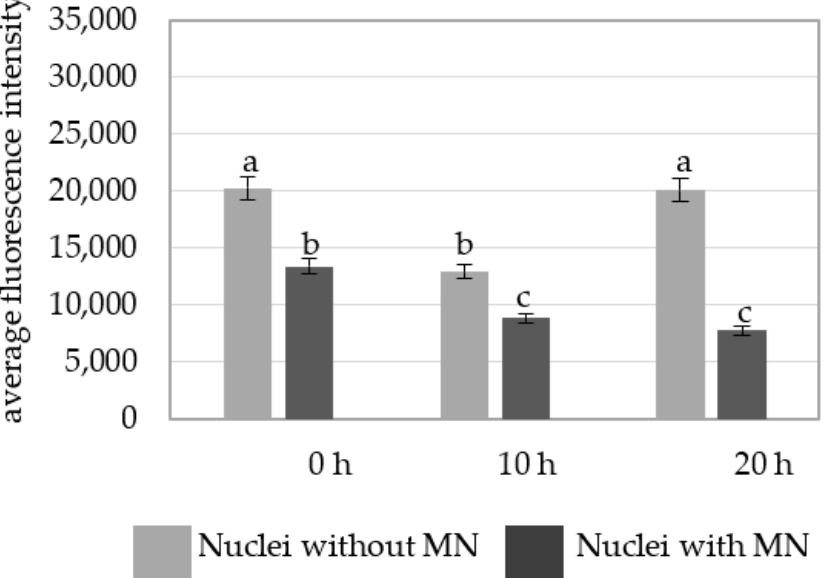
Figure 6. A comparison of the average fluorescence intensity of Alexa 488 that was used to detect 5 mC in the B. distachyon nuclei with and without micronuclei in the MH-treated cells at different posttreatments times. Fluorescence of Alexa 488 was measured in relative units. ANOVA followed by Tukey HSD test, p < 0.05; mean ± SD, statistically significant differences are indicated by different letters.